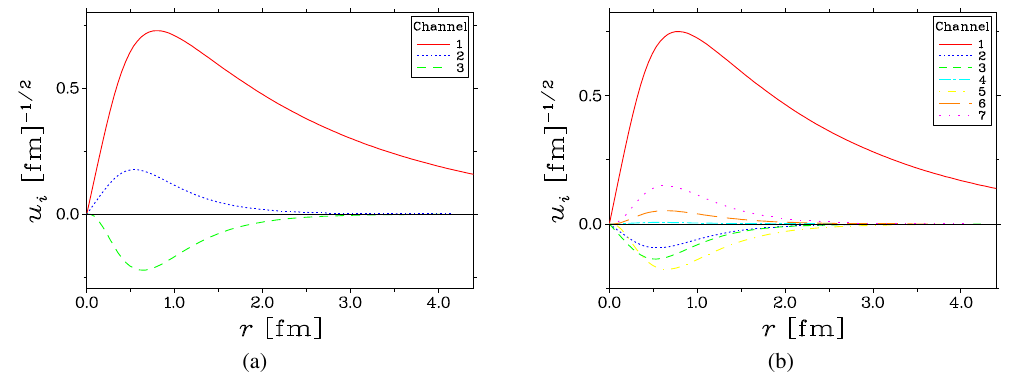
Fig. 1. The wave functions u i ( i = 1,2, ..., 7) of di ff erent channels with Λ π = 1 . 3 GeV in the OPEP model: (a) J P = 0 + case, (b) J P = 1 +